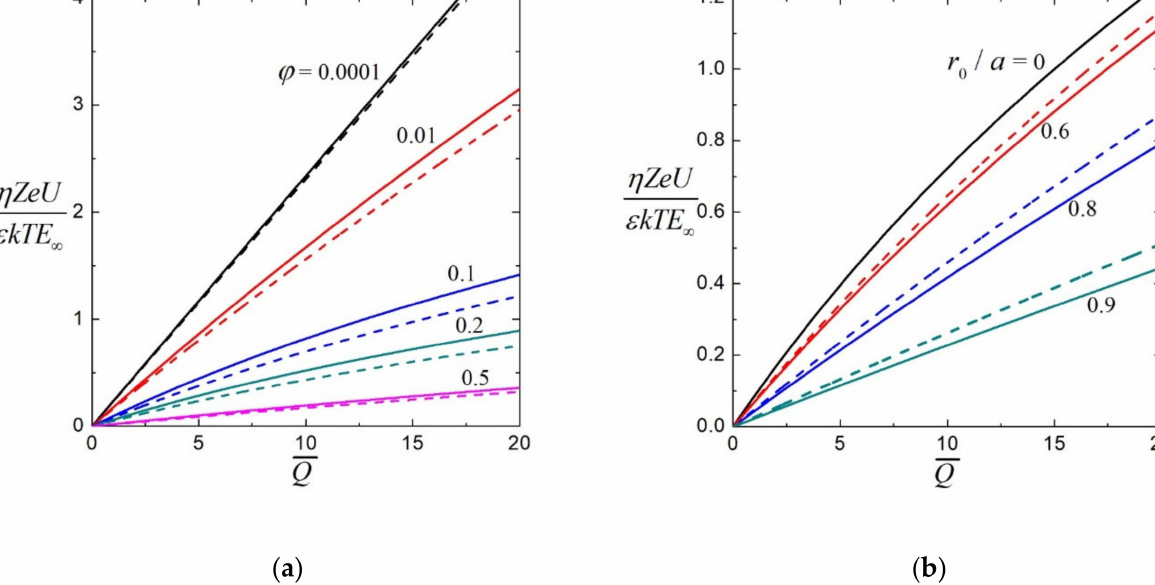
Figure 4. Scaled electrophoretic mobility η ZeU / ε kTE ∞ versus Q for a suspension of soft spheres with λ a = 10: ( a ) r 0 / a = 0 (porous spheres) with the solid and dashed curves representing calculations for the Happel and Kuwabara models, respectively; ( b ) ϕ = 0.125 for the Happel model with the solid and dashed curves denoting results obtained from conditions (13) and (14), respectively, at the cell